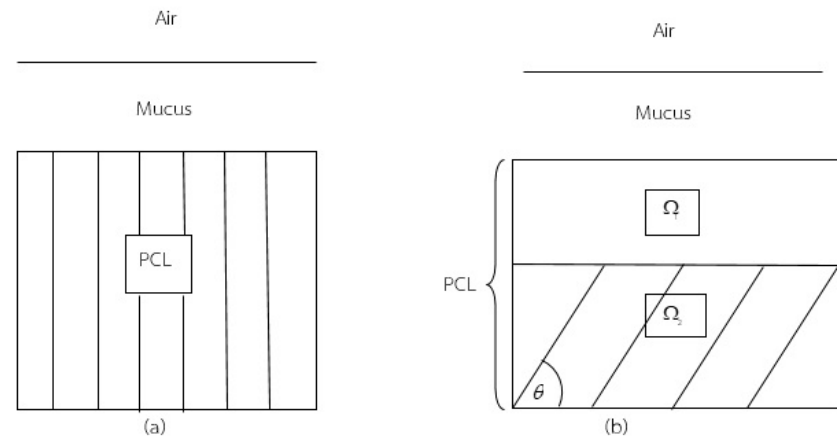
Figure 4. Cartoon picture of cilia ( a ) cilia are perpendicular to the horizontal plane; ( b ) cilia make angle θ , θ < 90 · with the horizontal plane. Ω 2